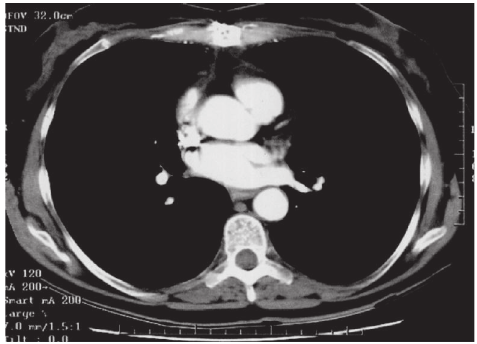
Figure 2: Cardiac mass on CT scan after